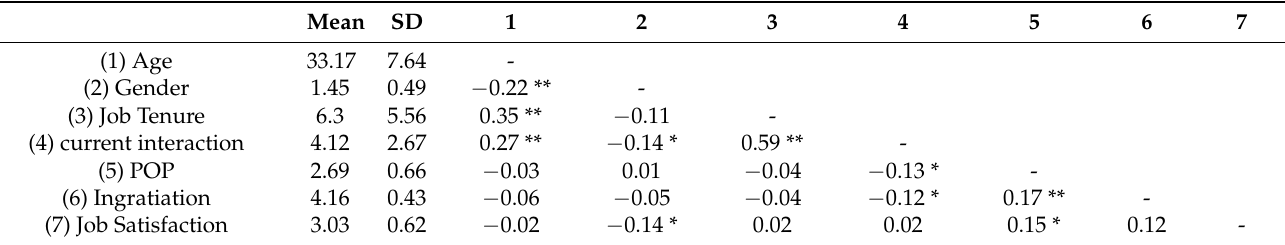
Table 1. Descriptive statistics and zero-order correlations of study variables.